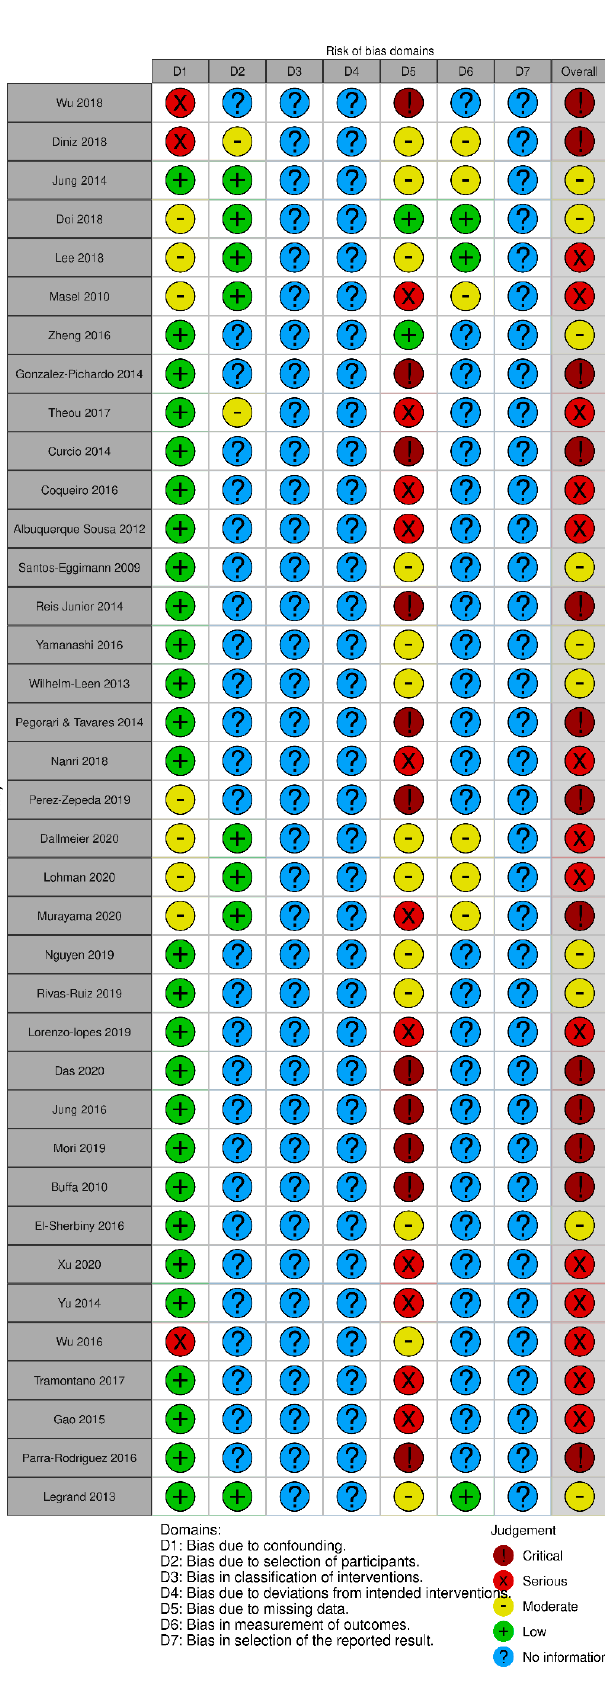
Figure 5. Risk of bias summary for each included study.